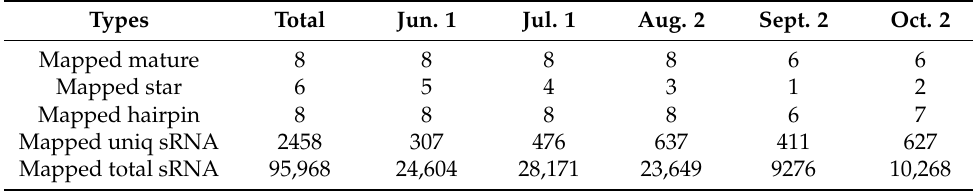
Table 4. Summary of mapped mature and hairpin in novel